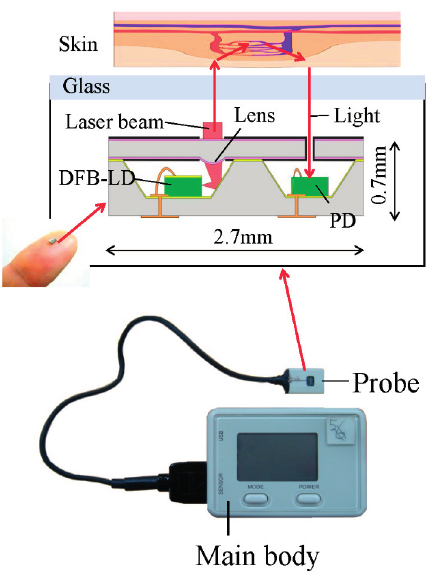
Figure 1. MEMS blood flow sensor. An image of the MEMS blood flow sensor (bottom) and schematic of the optical MEMS chip. The optical MEMS chip is located within the probe of the MEMS blood flow sensor. Silicon cavities are sealed with an upper silicon plate comprising a micro